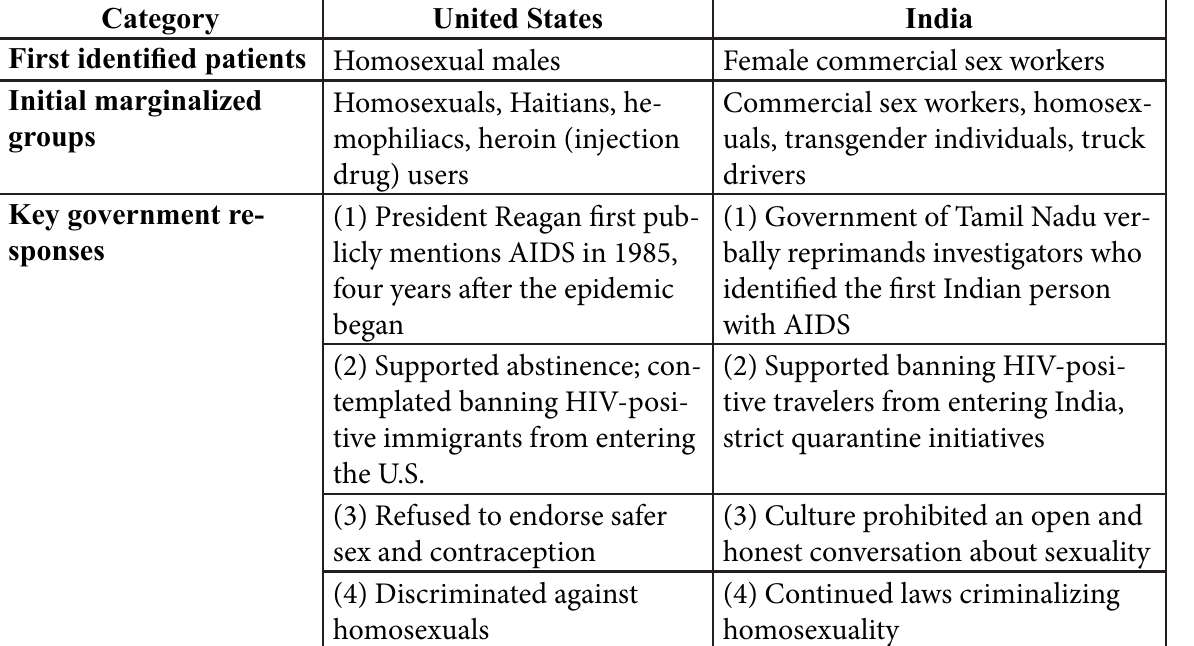
Table 1. Early Responses and Characteristics of the AIDS Pandemic in the United